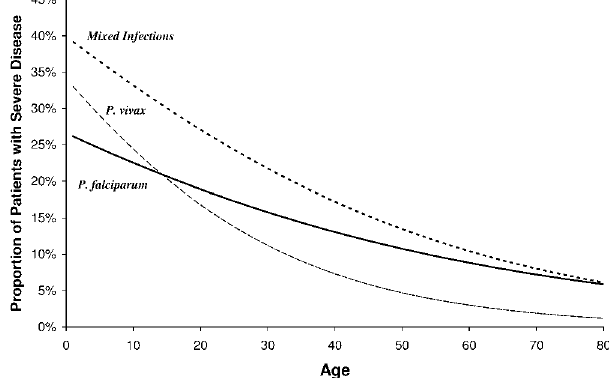
Figure 4. Age-Specific Risk of Severe Disease in Patients Admitted with P. falciparum (Bold Line), P. vivax (Hashed Line), and Mixed (Dotted Line) Infections Lines represent predicted values from a logistic regression model in which age was entered as a linear effect, along with an interactive term for age and species. doi:10.1371/journal.pmed.0050128.g004 PLoS Medicine |